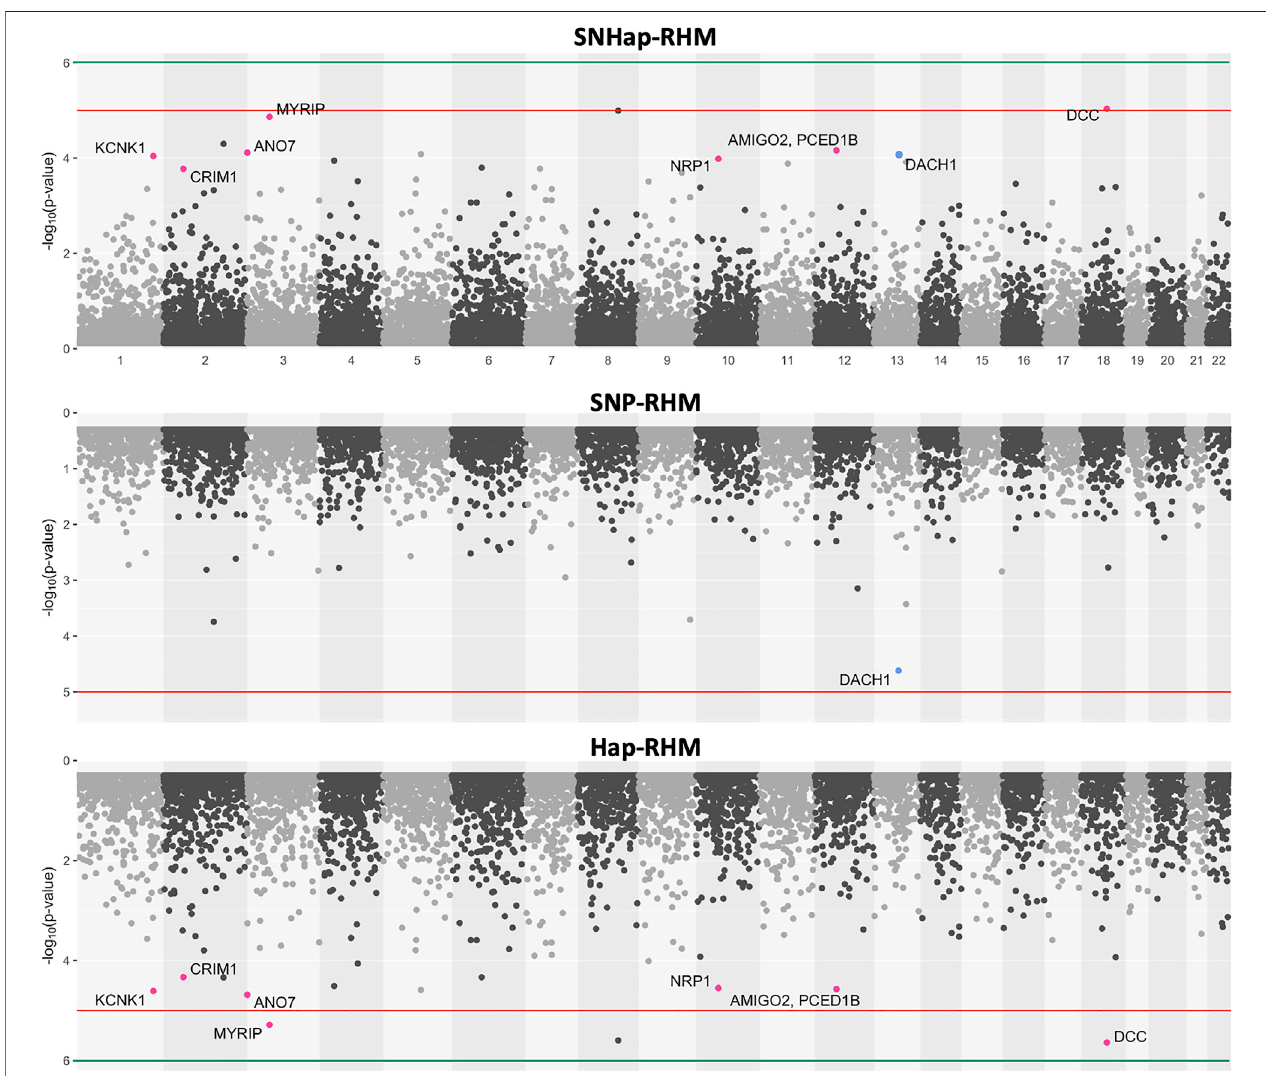
FIGURE 6 | The genome-wide evidence of haplotype block association for Major Depressive Disorder. Analysis done with SNHap-RHM, SNP-RHM and Hap- RHM. The points are plots of − log10 of the p -values of regions tested with the LRT for the regional GREML analyses. The green lines are the Bonferroni-corrected